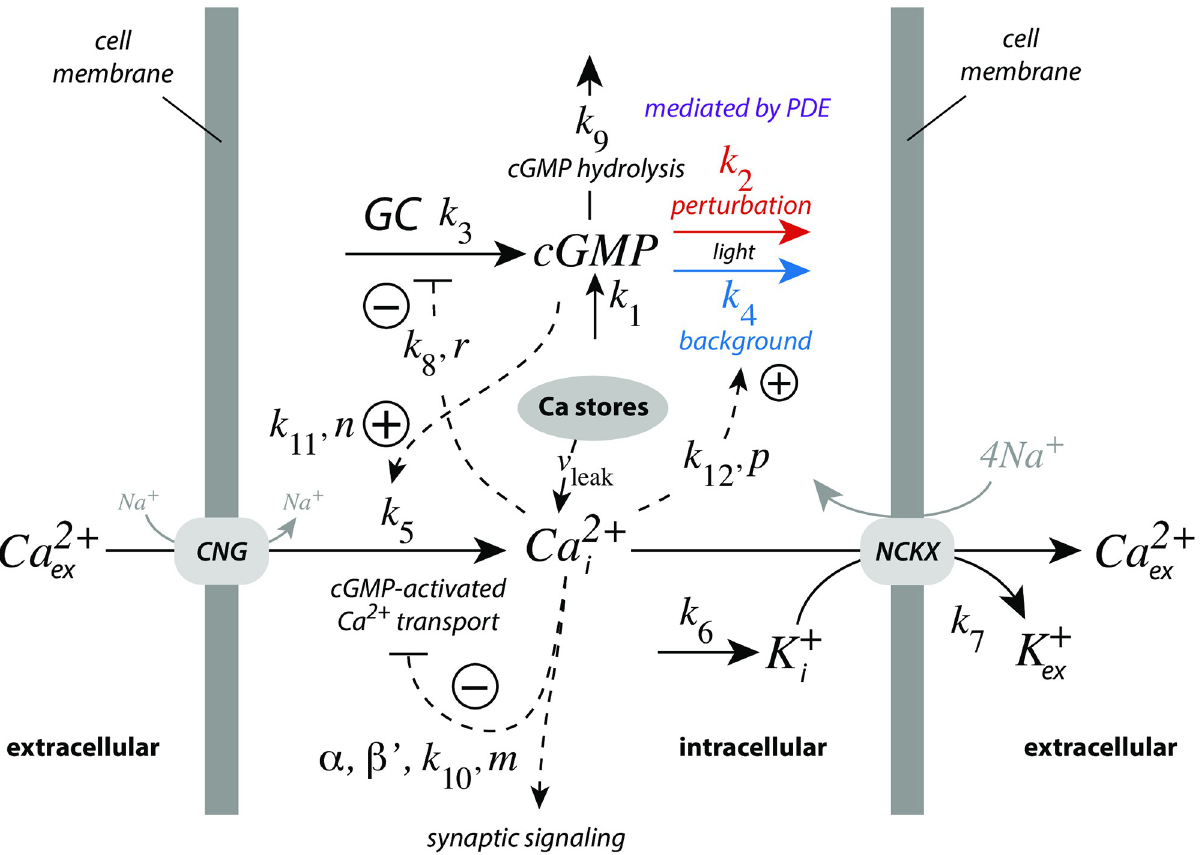
Fig 13. Model with the main regulatory elements of vertebrate photoreceptor adaptation. Light leads to the removal of cyclic guanosine monophosphate (cGMP) by phosphodiesterases (PDE), via transducin and the activation of PDE by internal Ca 2+ ( Ca 2 þ ). In the figure this path is split i into two components, one background with rate constant k 4 (outlined in blue), and a perturbation on top of the background (rate constant k 2 , outlined in red). cGMP is formed by guanylate cyclase (GC). cGMP’s constitutive non-light induced hydrolysis is described by a first-order reaction with rate constant k 9 . GC is inhibited/derepressed by Ca 2 þ to keep cGMP under homeostatic control. cGMP activates cyclic nucleotide-gated (CNG) channels, i levels inhibit CNG channels. Calcium is removed from the cell by potassium-dependent which leads to the inflow of Ca 2+ into the cell, while high Ca 2 þ i sodium-calcium exchangers (NCKX). Rate equations and used rate parameter values are described in the main text. Grayed reaction arrows indicate reactions which are not included in the